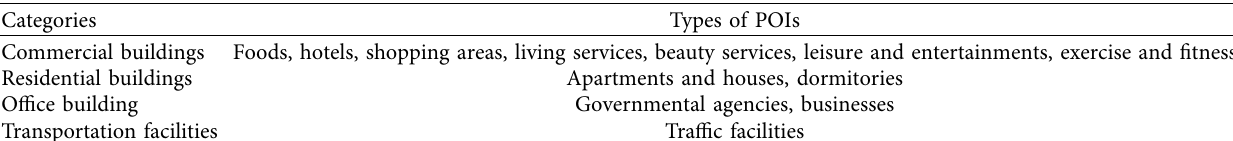
Table 1: Categories of POIs.